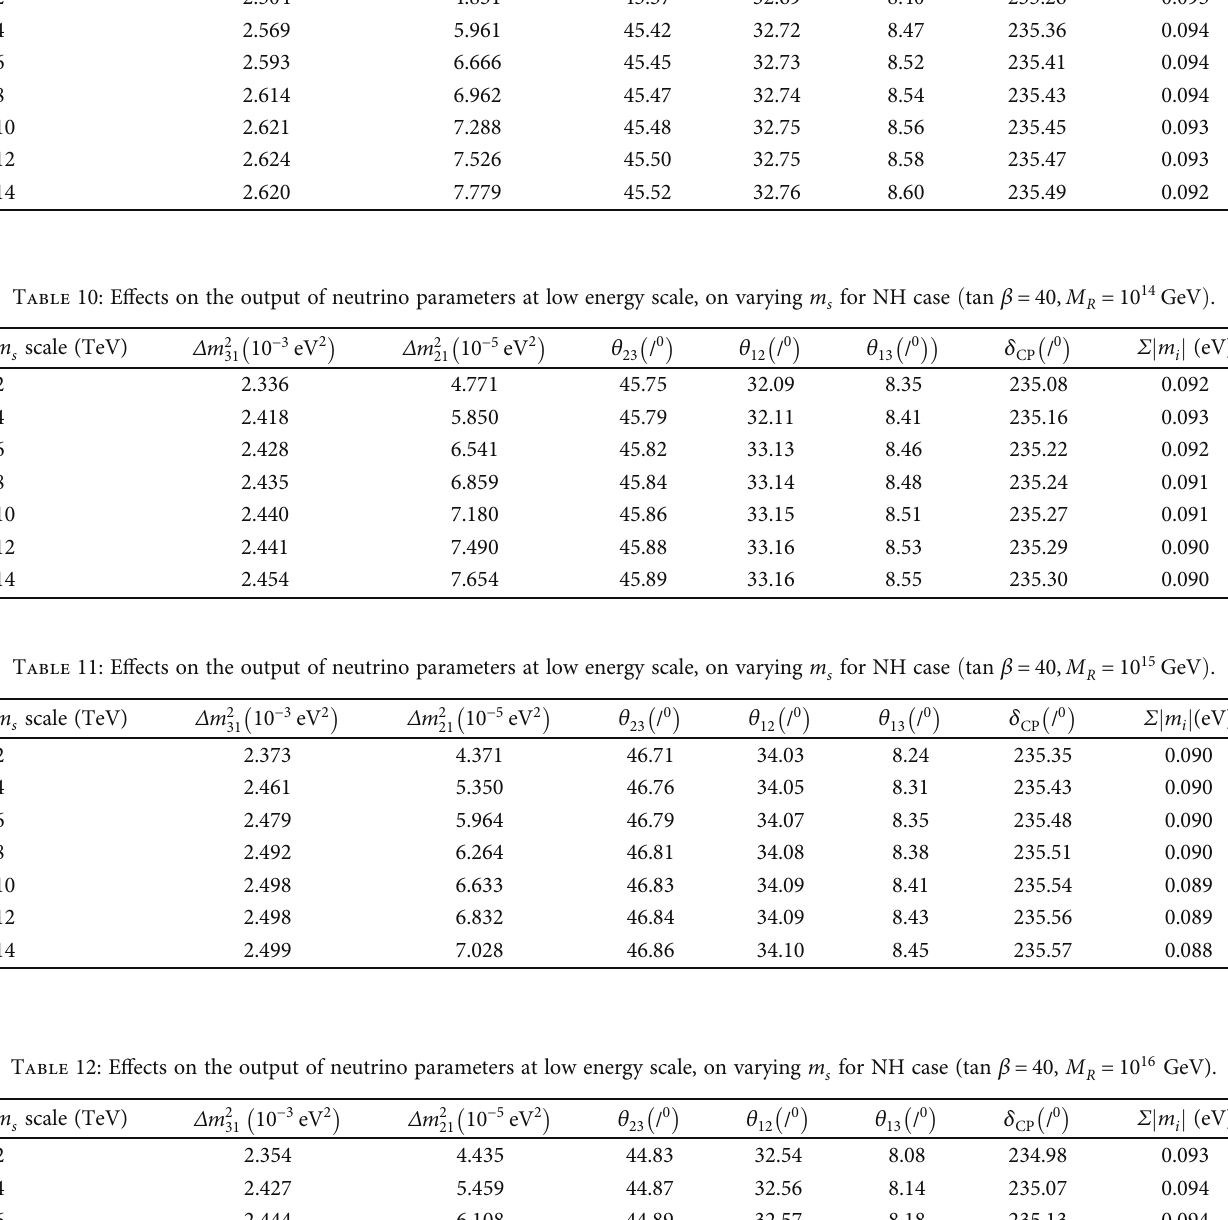
Table 9: E ff ects on the output of neutrino parameters at low energy scale, on varying m scale (TeV) m s